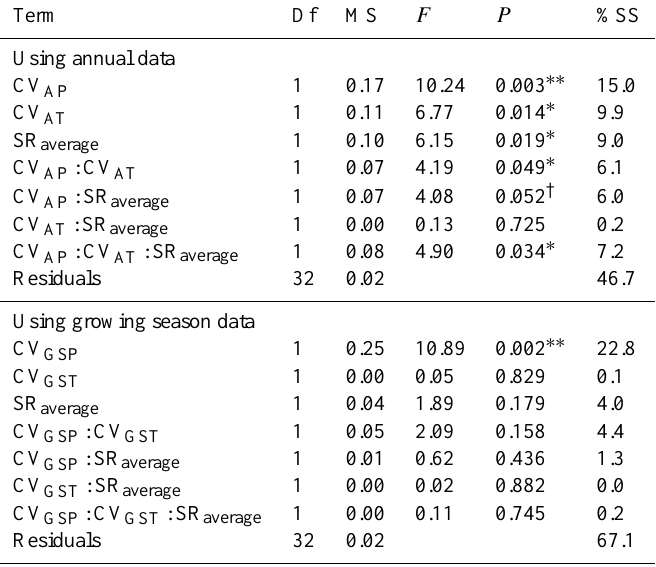
Table 5. Summary of GLM for the effects of climate fluctuation and species richness (SR) on the interannual variation of aboveground primary production (ANPP). AP: annual precipitation; AT: annual temperature; GSP: growing season precipitation; GST: growing season temperature; CV: coefficient of variation; %SS: percentage of total sum of squares explained. ∗∗∗ P < 0 . 001; ∗∗ P < 0 . 01; ∗ P < 0 . 05; † P < 0 .